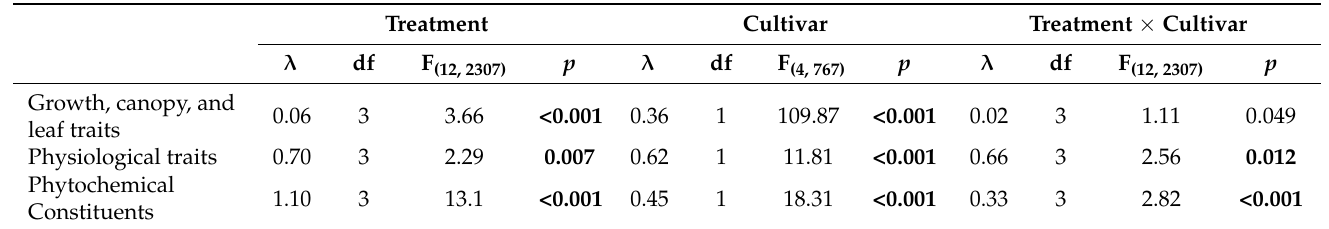
Table 1. MANOVA results testing the effect of treatment (control, defoliated, herbicided, and girdled) on responses of two red maple ( Acer rubrum ) cultivars (‘Brandywine’ and Franksred’). Significant values are in bold .